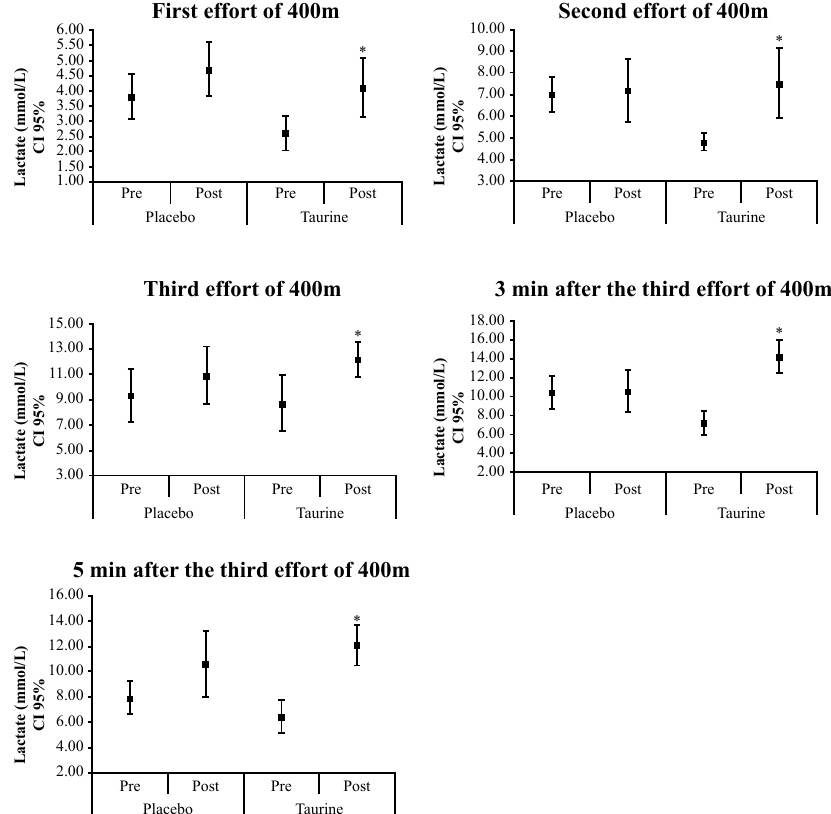
Figure 3. Evaluation of blood lactate concentrations (mmol/L) before (Pre) and after (Post) 8 weeks of placebo or taurine supplementation (n = 14). * Statistical difference in relation to “Pre Taurine” at p ≤